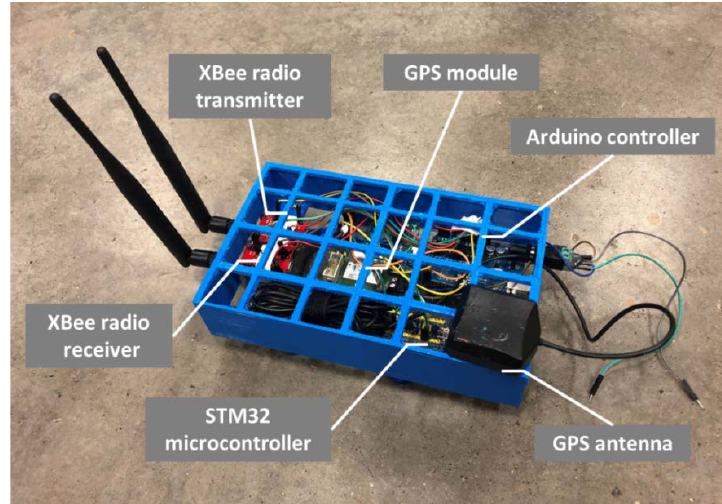
Figure 4. View of the modified RTK-GPS system onboard the UAV, consisting of a GPS module, Arduino controller, a GPS antenna, a STM32 microcontroller, and two XBee radio devices.